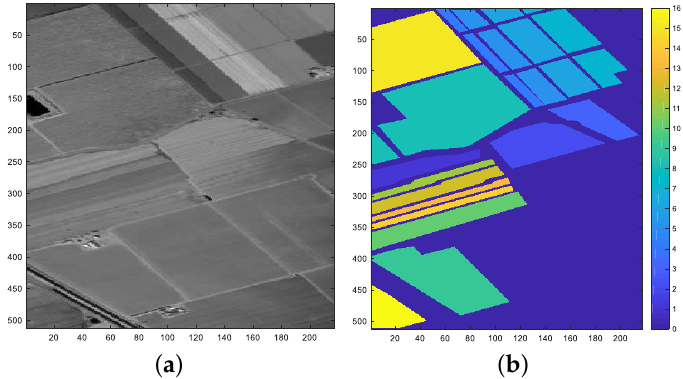
Figure 13. Band 100 and the ground truth of the Salinas dataset. ( a ) Band 100. ( b ) The ground truth (label 0 denotes background).